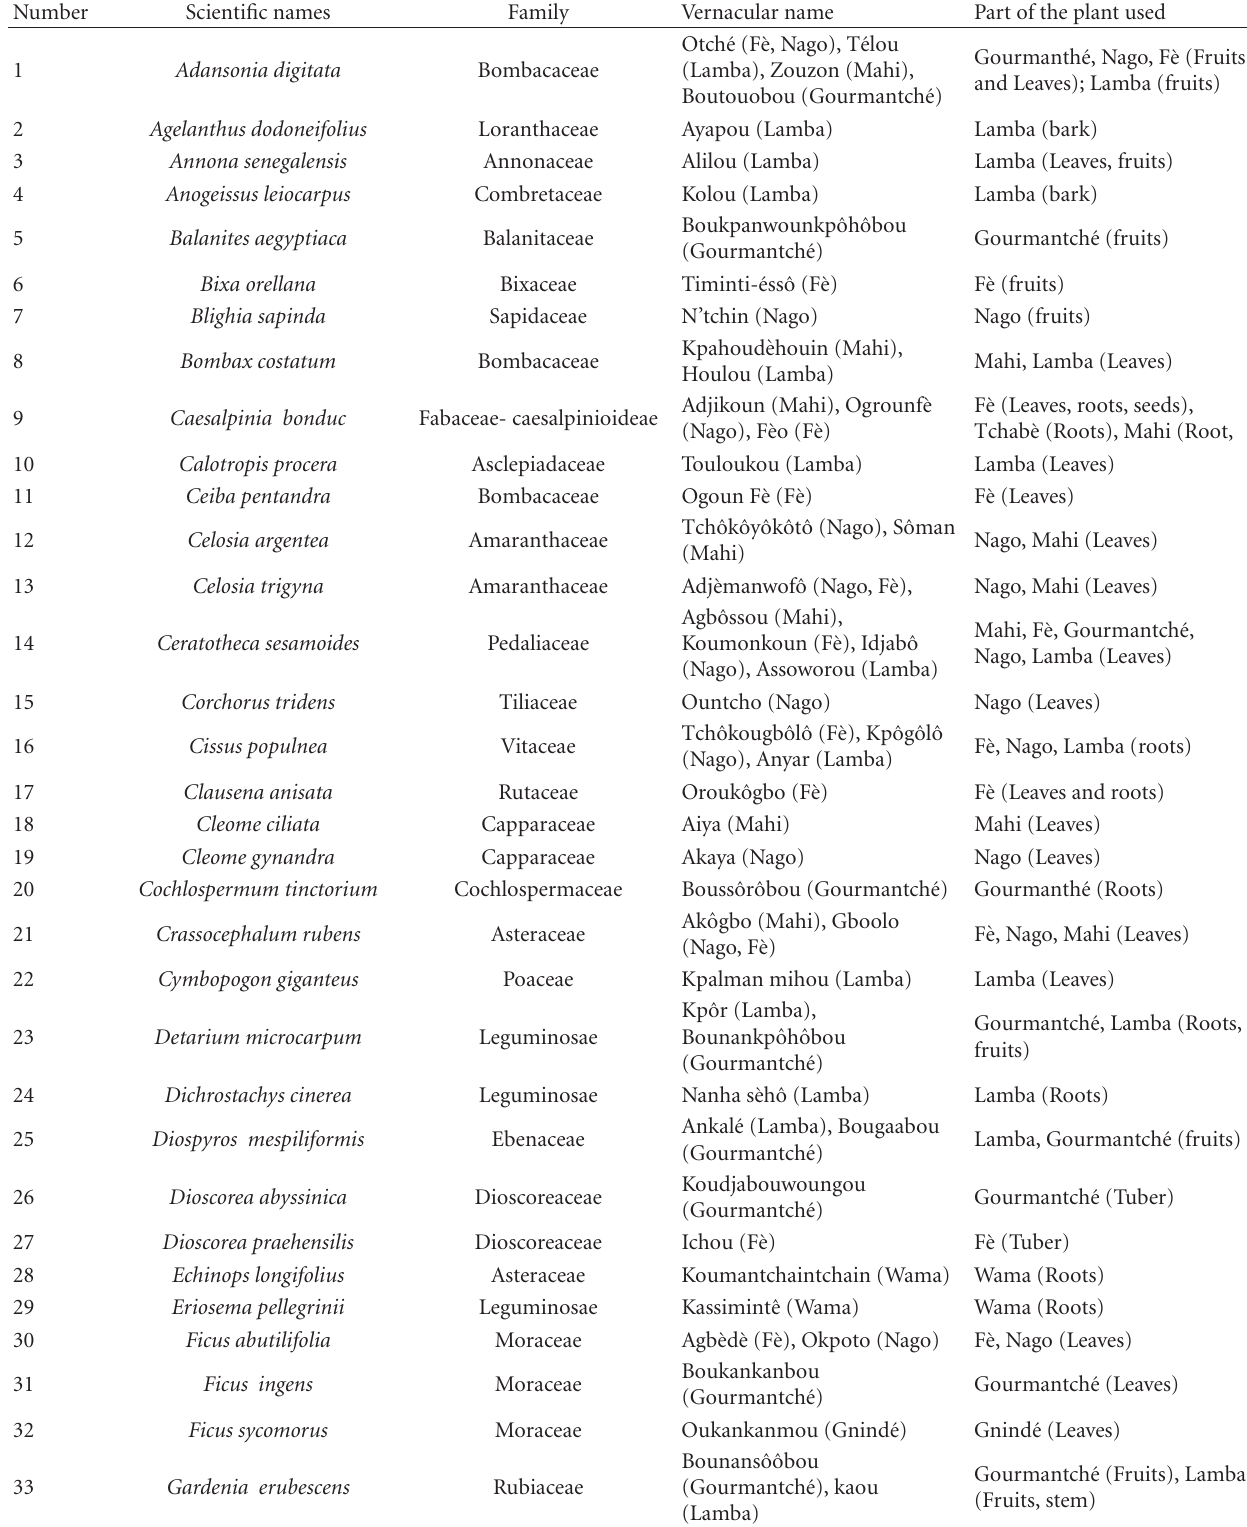
Table 1: Diversity, vernacular names, and utilisation of the species under domestication across ethnic